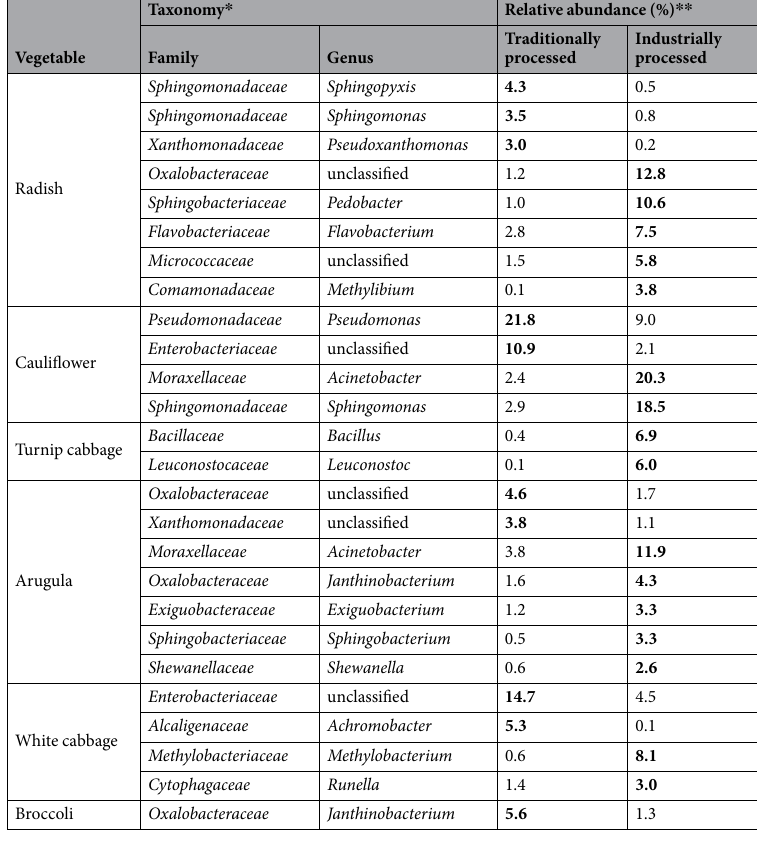
Table 1. Significant differences in relative abundances between traditionally and industrially processed equivalents of each vegetable type. * Only taxa with abundance greater than 3% in one group, showing significant difference in abundance (p < 0.05) between the two groups are shown. No taxa meeting those criteria were found for horseradish. ** The values indicating higher abundances of the taxa at the respective processing pathway are highlighted in bold